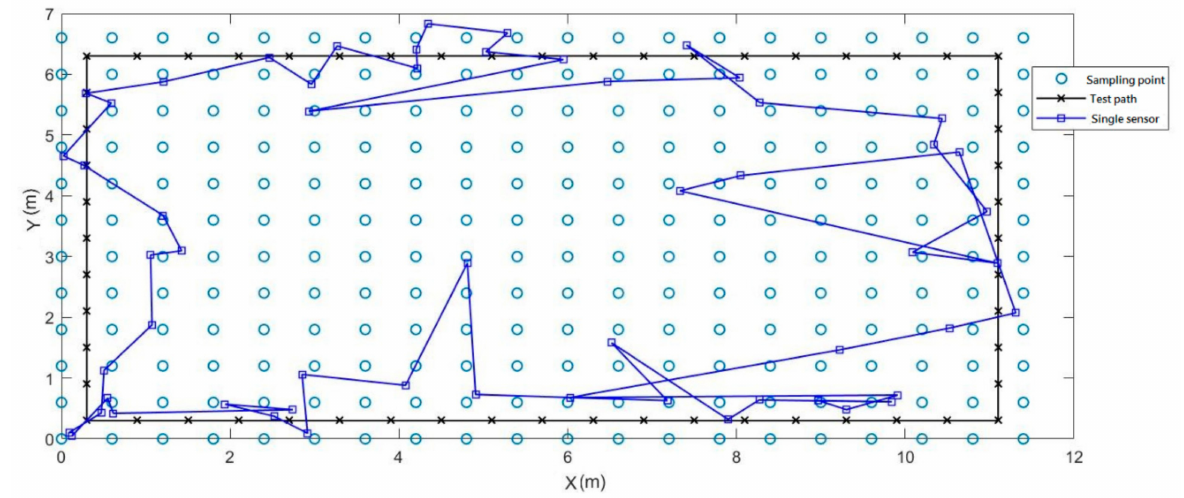
Figure 13. Indoor positioning experiment by single magnetic sensor.